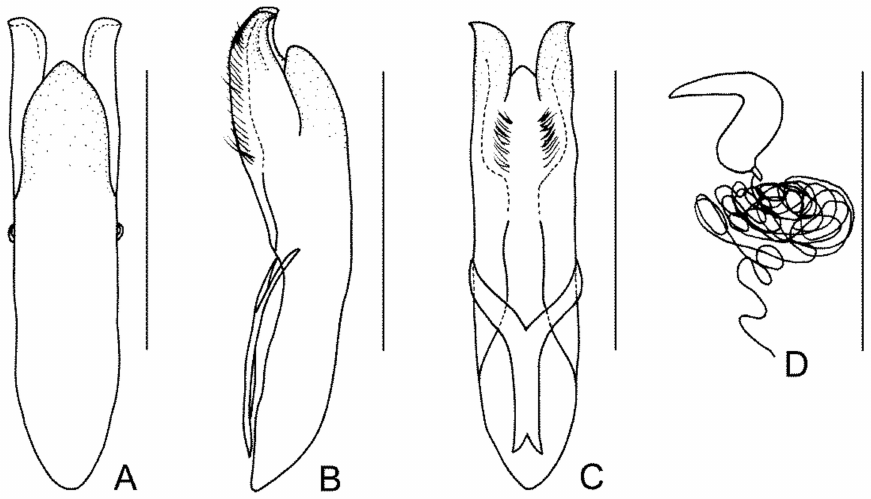
Figure 39. Cryptocephalus ( Burlinius ) yangweii Chen, 1942: ( A ) dorsal view of aedeagus; ( B ) lateral view of aedeagus; ( C ) ventral view of aedeagus; ( D ) spermatheca (Scale bars: 0.5 mm). The distribution is China (Zhejiang, Fujian, Jiangxi, Hubei,